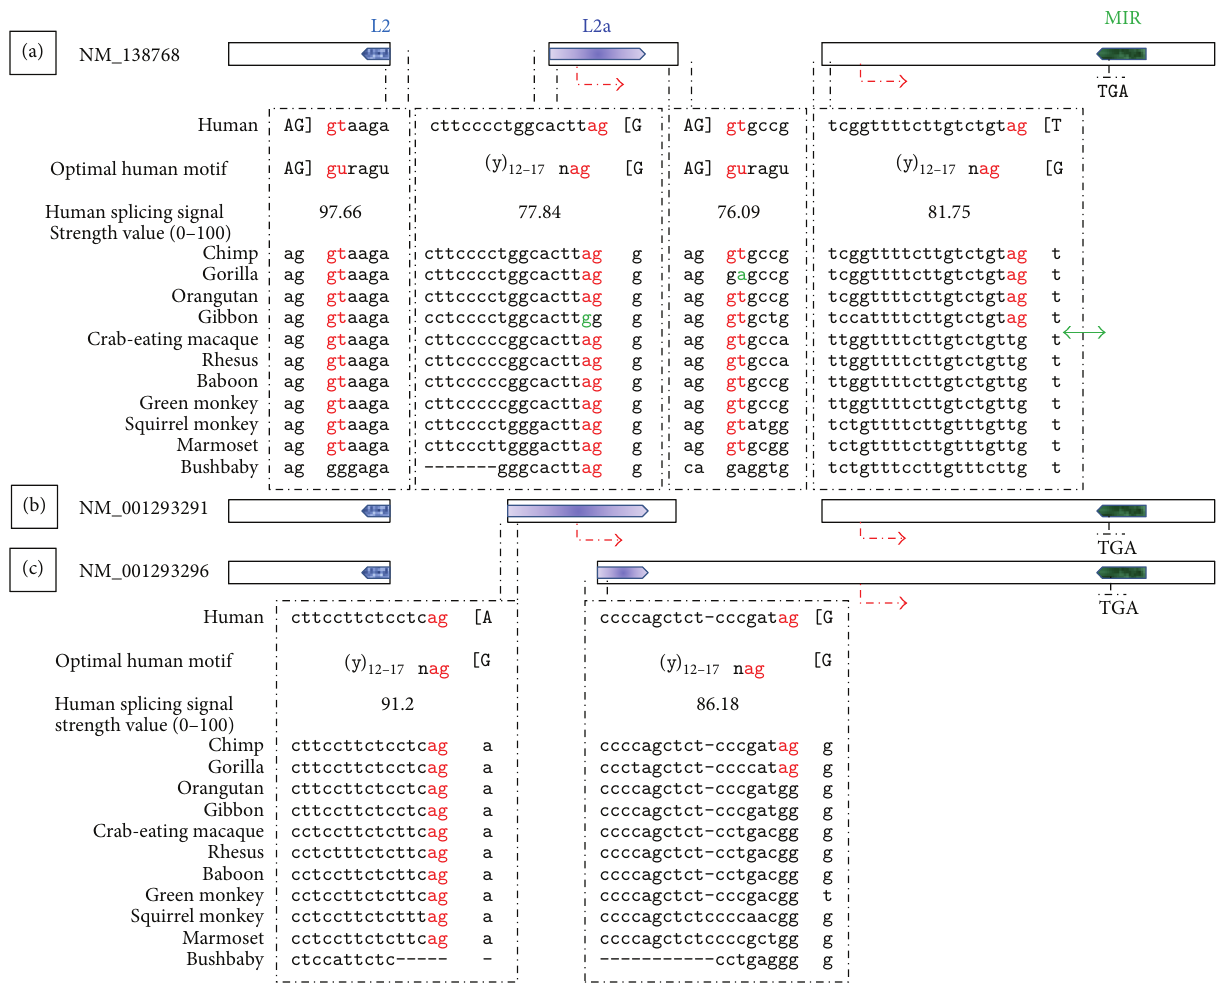
Figure 4: MYEOV splicing junctions. Illustrated are three MYEOV alternatively spliced variants (a–c), as described in Figure 1. Shown are the canonical 5 󸀠 /3 󸀠 splice sites that delimit all the putative splicing junctions of MYEOV , as annotated in the Gene database from NCBI. The splice sites are juxtaposed to the optimal core splicing signal motifs; corresponding splicing signal strength values are also shown. Upper- case nucleotides, delimited by brackets, versus lower-case nucleotides correspond to exonic versus intronic content, respectively. Nucleotides exerting the strongest influence on the signal strength appear in red font. Aligned below the human splicing signals appear corresponding nucleotide sequences from MYEOV syntenic region in 11 primates. Shown in green font are nucleotides that deviate from the evolutionary trend, requiring further validation. The double-headed green arrow points to the precious canonical acceptor that arose in hominoids, allowing for MYEOV long-ORF to occur. Alignment gaps correspond to indels located between the aligned blocks in the aligning